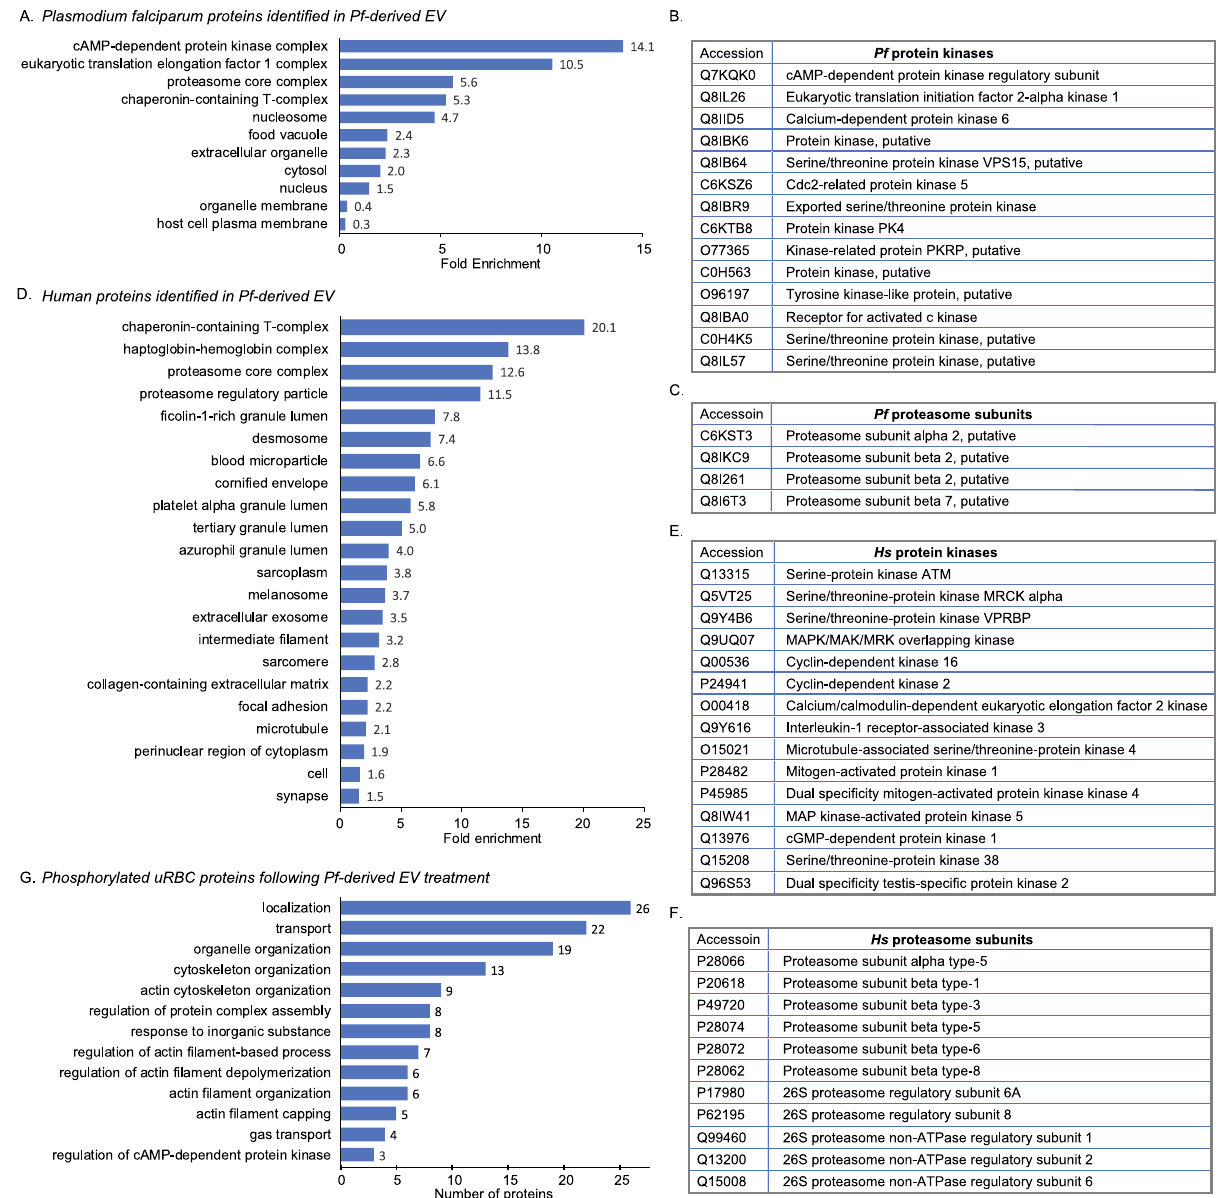
Fig. 2 Pf -derived EVs are enriched with kinases and proteasome subunits. Gene Ontology (GO) cellular components enrichment analysis of Pf -derived EV protein cargo. Vesicles were harvested and proteins were extracted and subjected to cellular components analysis following LC-MS/MS proteomic identi fi cation. The horizontal bar graph shows the fold enrichment of signi fi cantly enriched A Pf and D human proteins. Results are based on GO cellular component enrichment analysis of all identi fi ed proteins against the background of D Homo sapiens and A Plasmodium falciparum (http://geneontology.org/; p -value < 0.05, FDR<0.01). Lists of identi fi ed Pf and human ( B and E ) kinases and proteasome subunits ( C and F ). G Phosphoproteomics analysis of uRBCs treated with Pf -derived EVs. Identi fi ed proteins were subjected to GO Biological Processes analysis (FDR< 0.00035). Statistical analyses in A and D were done using PANTHER Statistical Overrepresentation Test (Released 2019-07-11). Annotation versions and release date: GO Ontology database (Released 2019-10-08), PANTHER version 15 (Released 2020-02-14). Analyzed lists: Homo sapiens or Plasmodium falciparum Proteins IDs (Uniprot Accessions are listed in Table S1A, S1B). Reference list: Homo sapiens or Plasmodium falciparum (all genes in database). Test Type: FISHER, applying FDR correction, p <